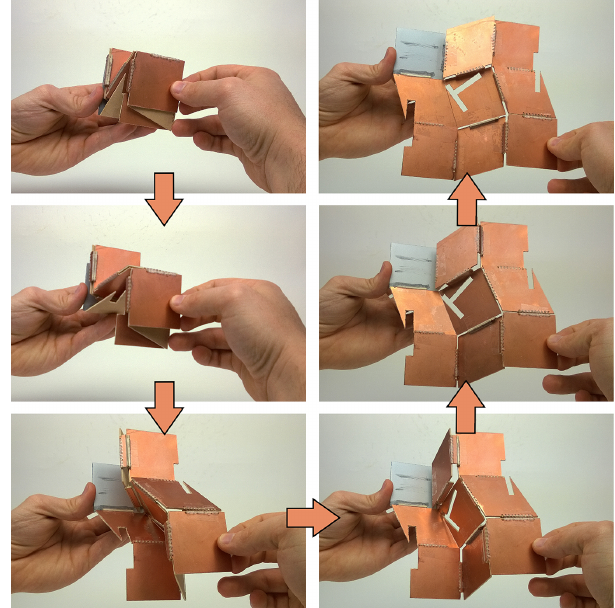
Figure 4. In the kinetic sculpture, the grounded panel is made of MDF while all others are made of a foam board.